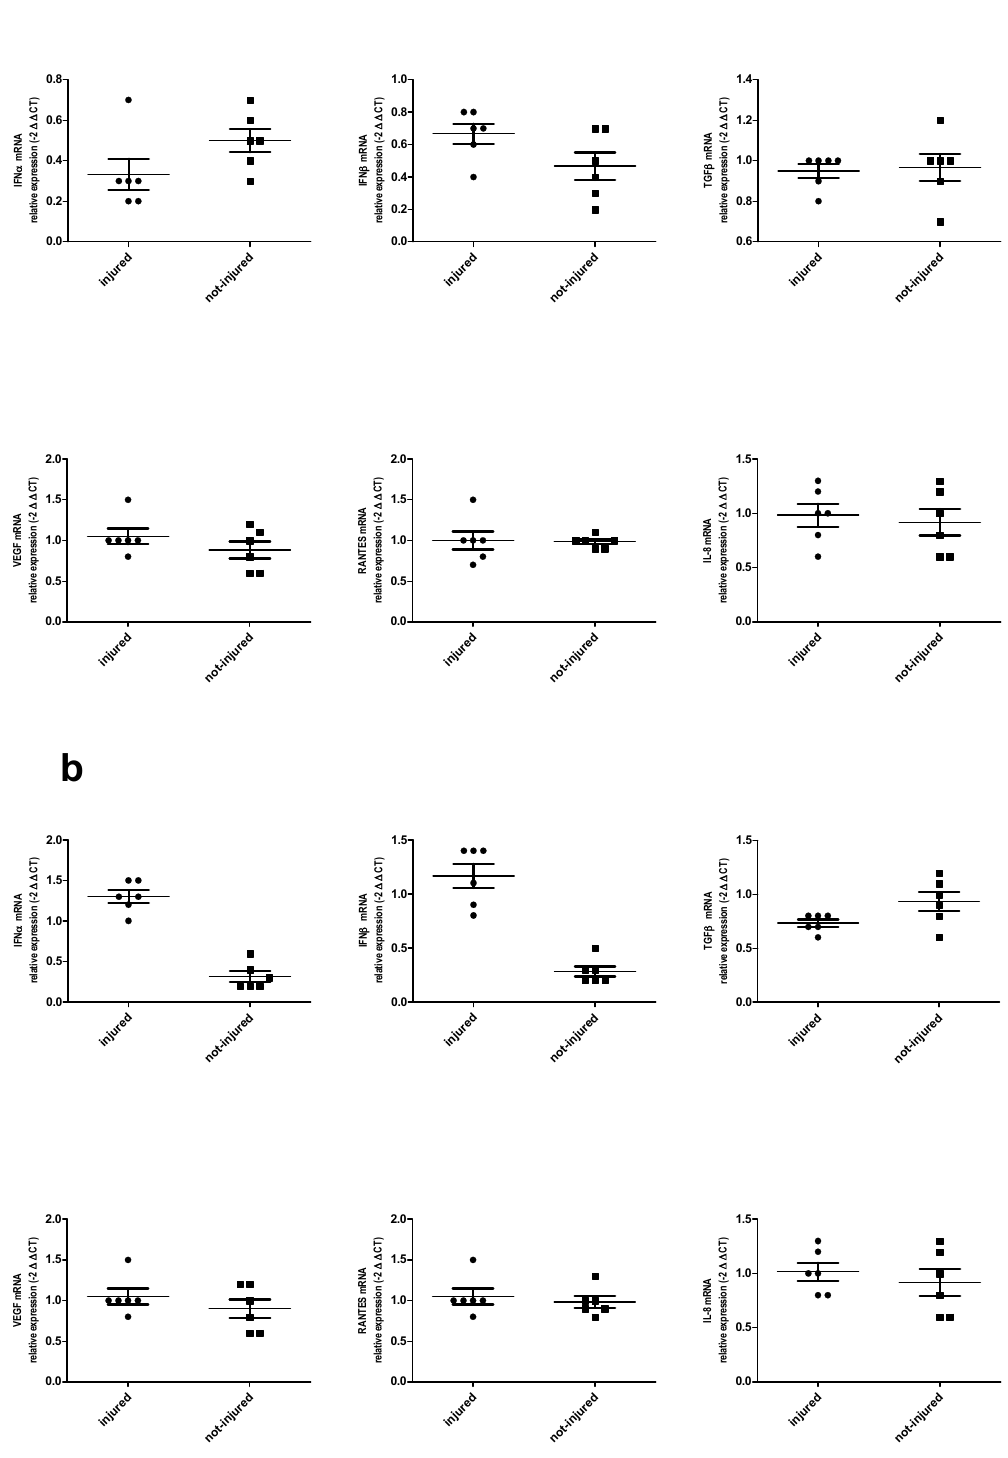
Figure 9. LPS—( a ) and poly (I:C)—( b ) induced cytokine expression in injured and not-injured cells.